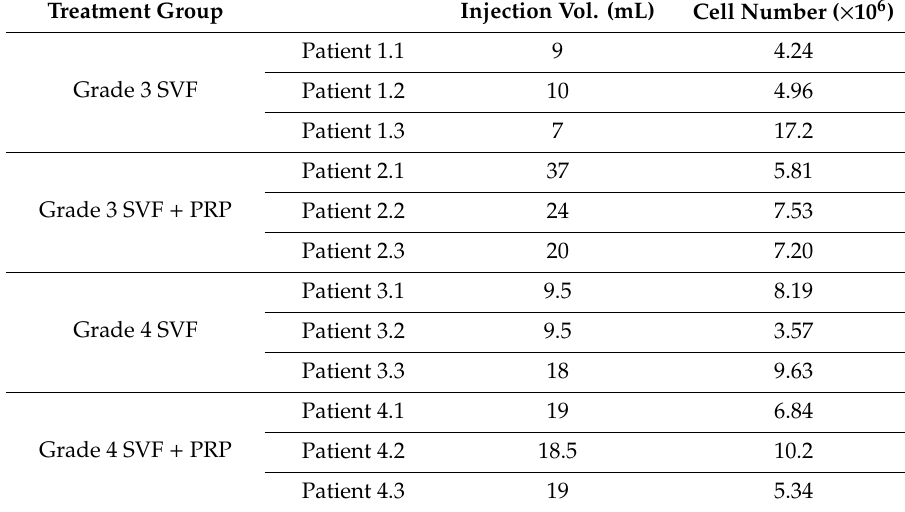
Table 2. Cell numbers and injection volumes for the treatments of knee osteoarthritis of one single knee joint with freshly isolated SVF from the adipose